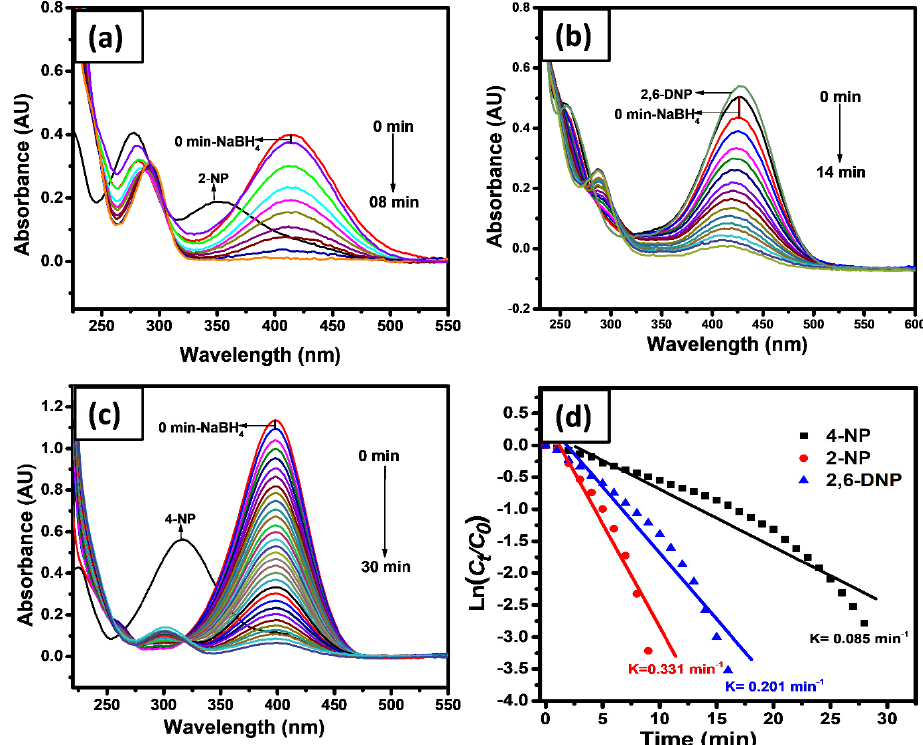
Figure 5. Typical UV-visible absorbance spectra of 2-NP ( a ), 2,6-DNP ( b ), and 4-NP ( c ) and their ln( A t / A 0 ) vs. time plot for the reduction reactions where the amount of the GL/Co-SnO 2 catalyst used was 0.2 gm ( d ).